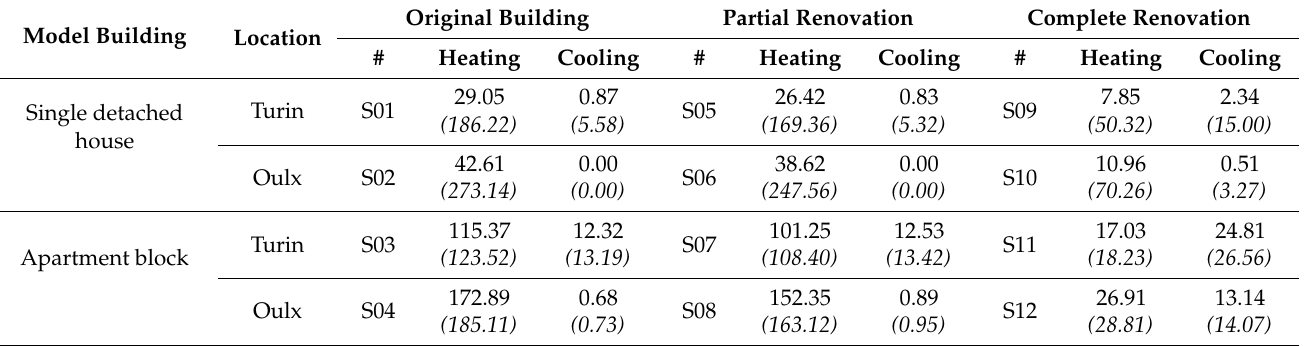
Table 2. Heating and cooling demand (MWh/year) and, between brackets and in italics, the demand per unit heated/cooled area (kWh/m 2 /year) of the modelled